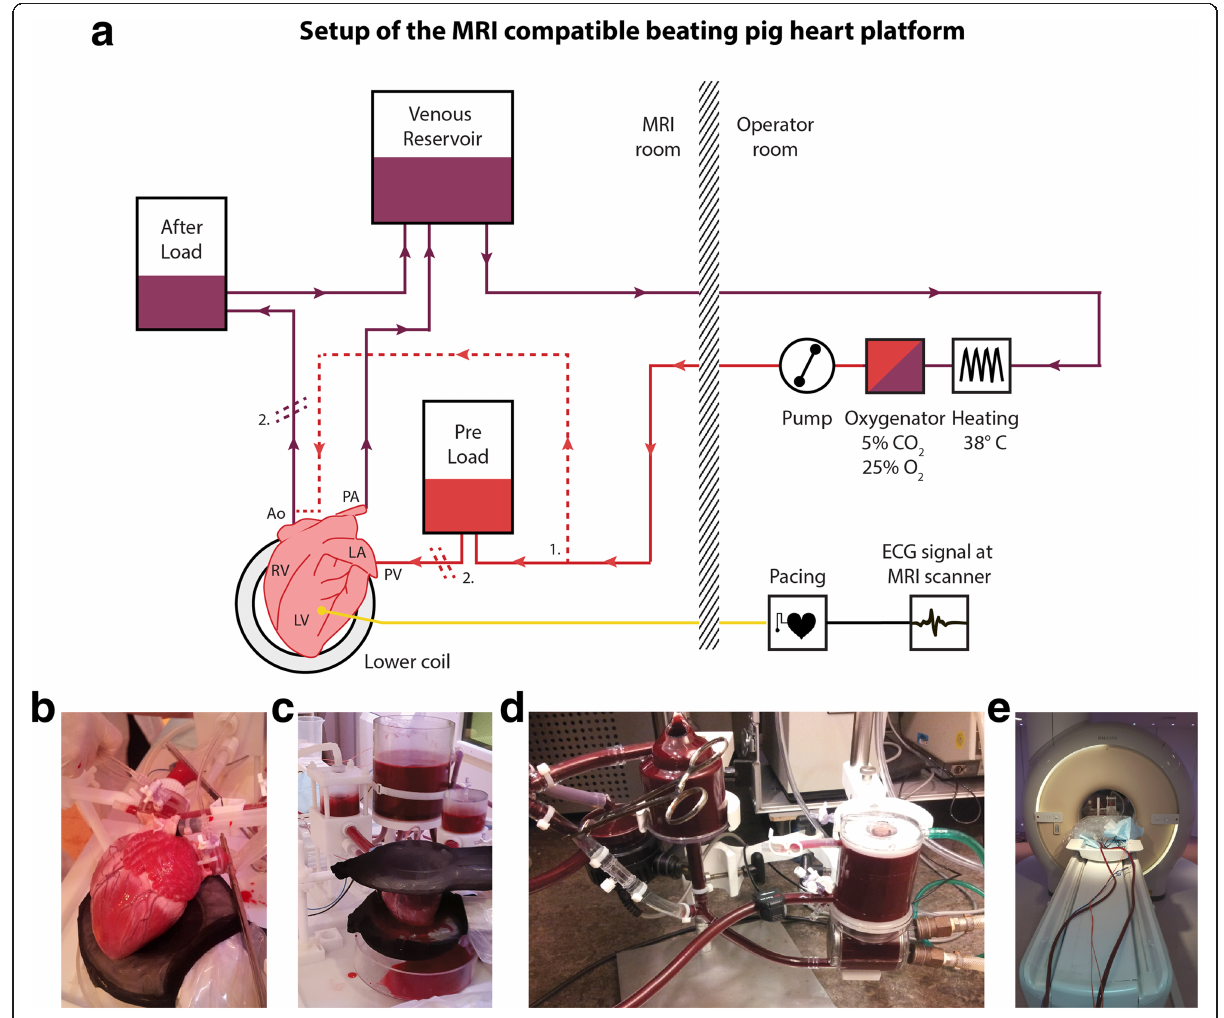
Fig. 1 Experimental setup of the MRI-compatible beating pig heart platform. a Experimental setup of the MRI-compatible PhysioHeart TM platform (LifeTec, Eindhoven, The Netherlands). The heart was connected to a preload and afterload system. The venous blood (purple) was heated and oxygenated outside the MRI room and pumped back to the experiment afterwards (red). The dotted lines indicate (1) coronary perfusion during the Langendorff mode and (2) the cross clamping of the aorta and the pulmonary vein. Ao Aorta, LA Left atrium, LV Left ventricle, PA Pulmonary artery, PV Pulmonary vein, RV Right ventricle. b The heart during Langendorff perfusion, attached to the aortic cannula and the pulmonary vein cannula. c The resuscitated, beating pig heart installed in the platform between the two coils on the patient bed before scanning. d The heating device and oxygenator outside the MRI room. e Setup during the scan, with two tubes leading to the MRI operator